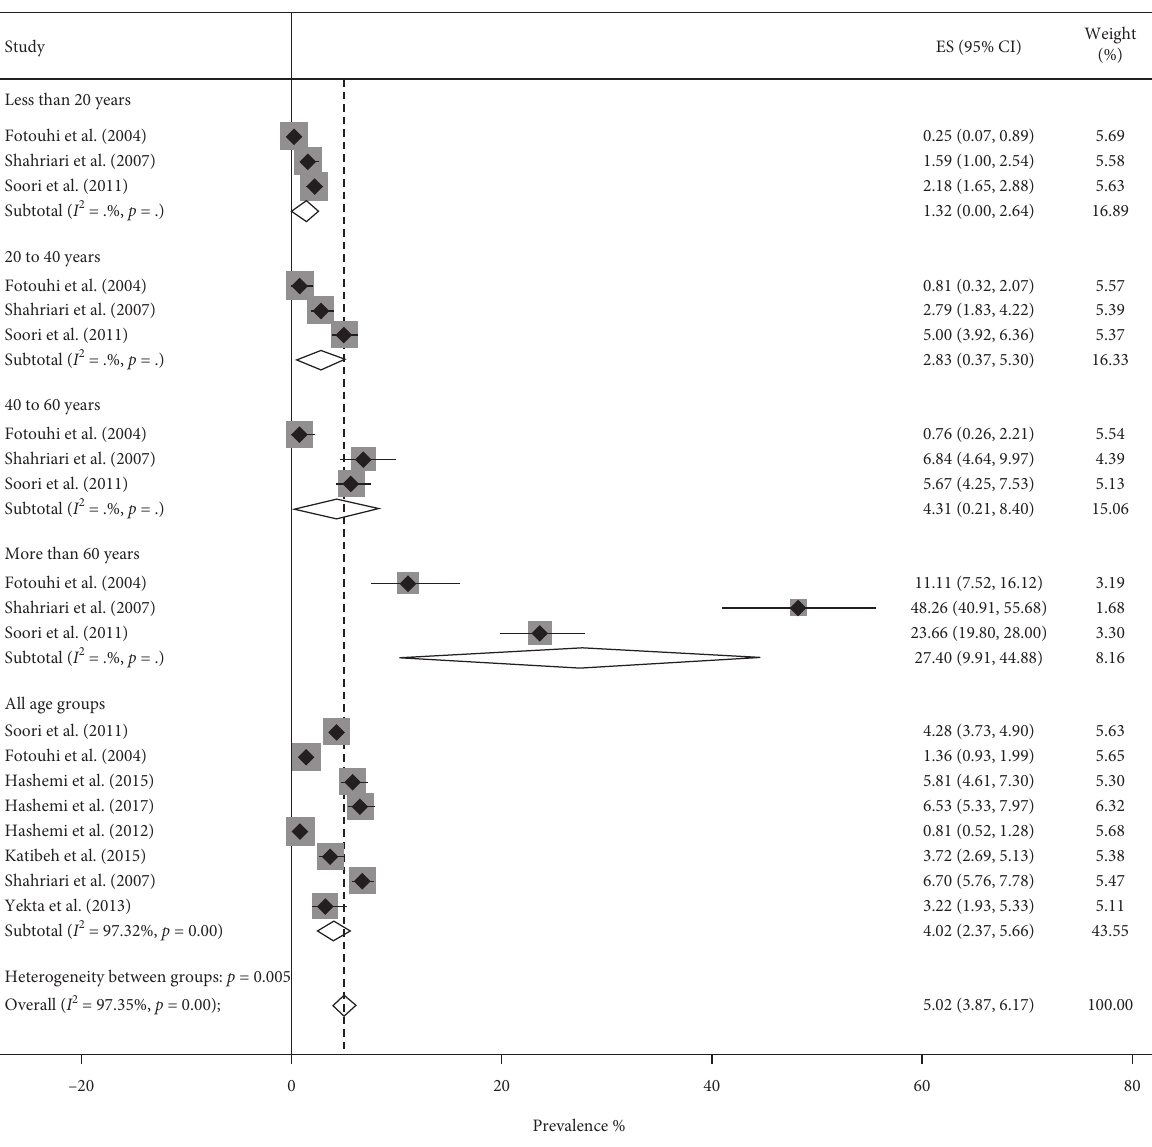
Figure 6: Forest plot of the prevalence of visual impairment among Iranian